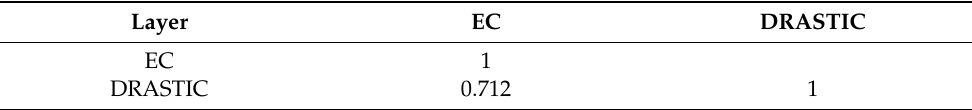
Table 7. Correlation matrix between EC and